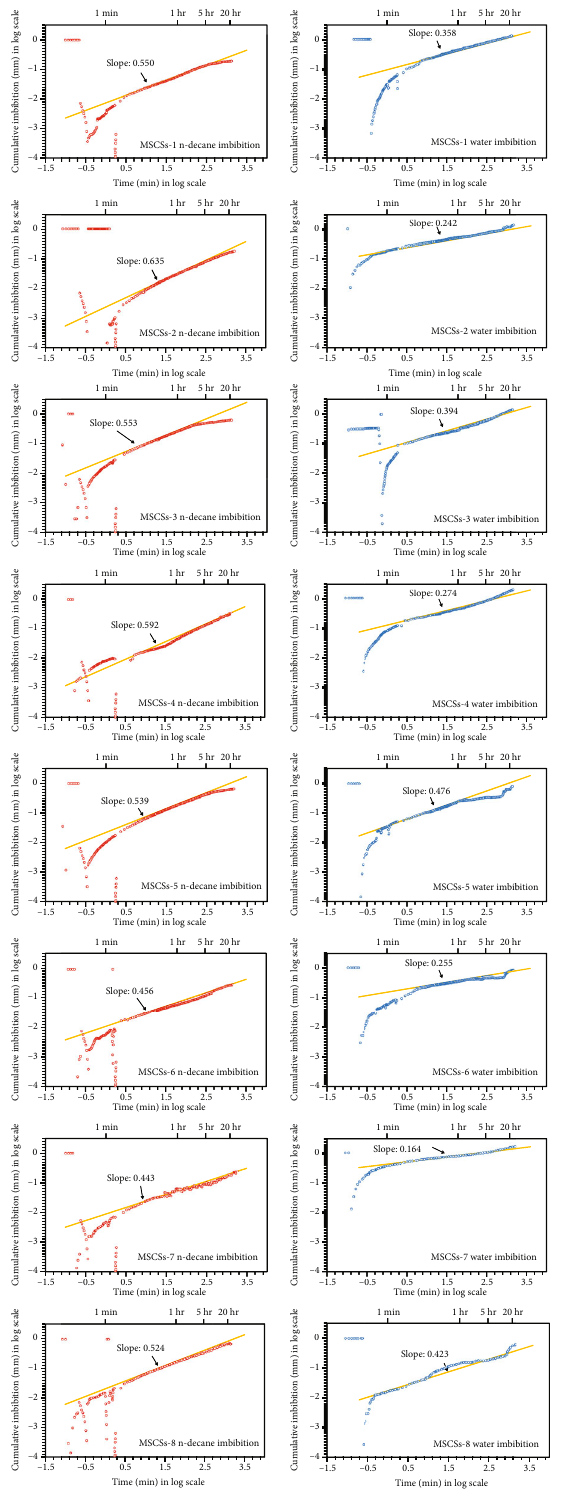
Figure 8: Connectivity of oil-wetting pores and water pores measured by spontaneous